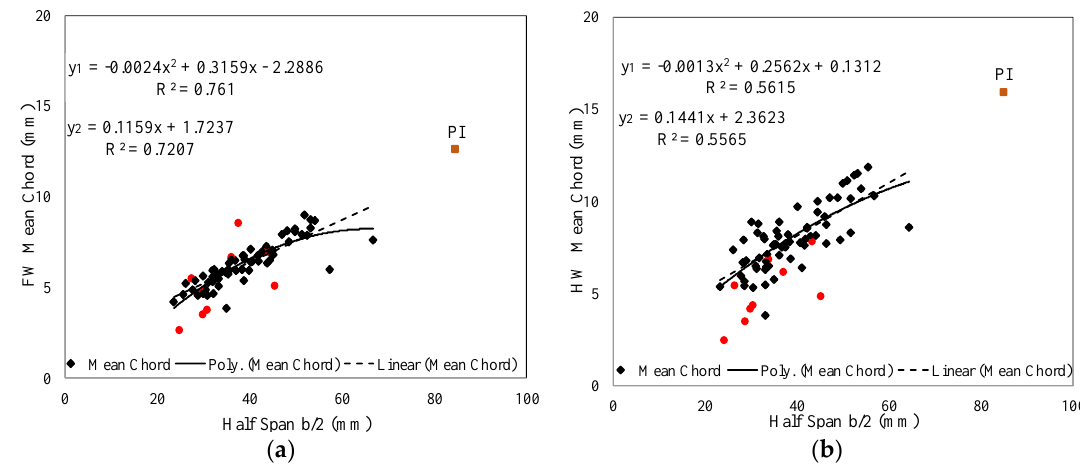
Figure 11. Mean chord versus wingspan of the forewings ( a ) of dragonflies, and mean chord versus wingspan of the hindwings ( b ) of dragonflies.